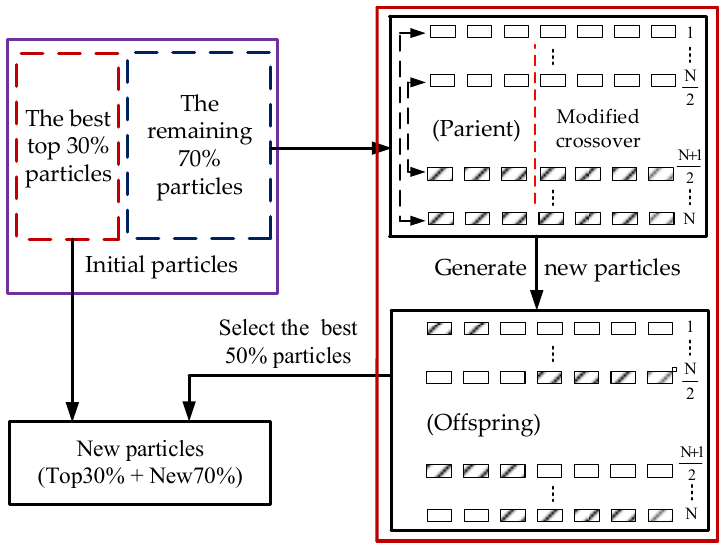
Figure 4. Selection rule of new particles in the hybrid particle swarm optimization (HPSO) method.